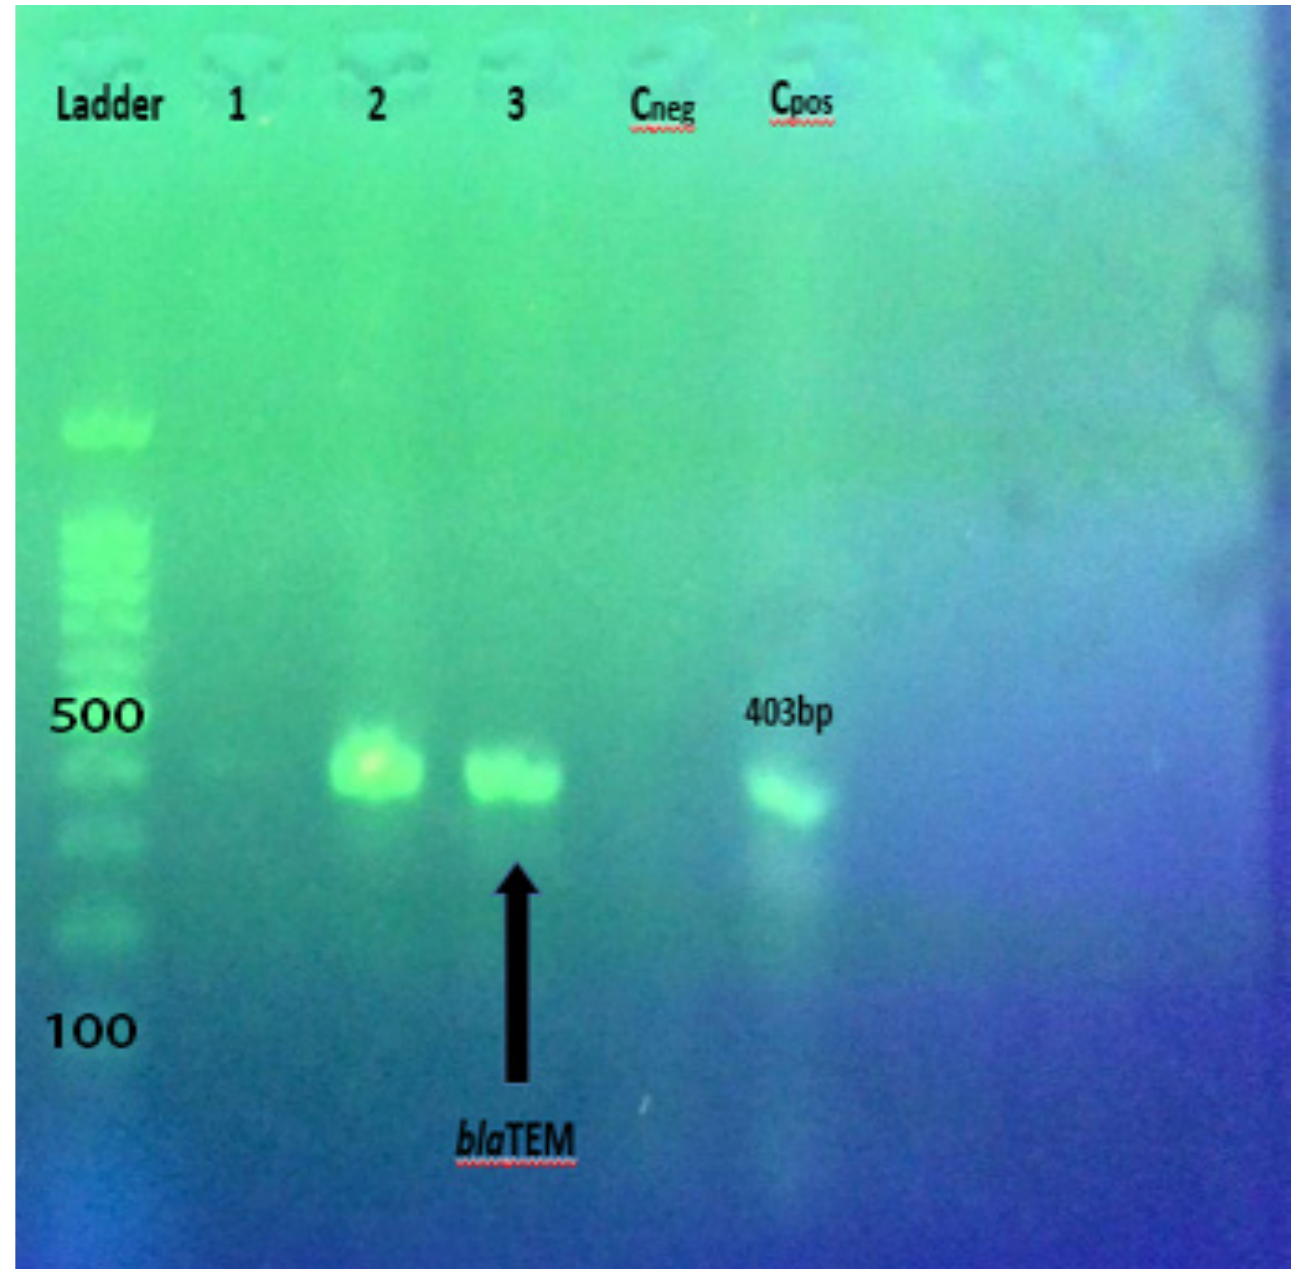
Figure 1. The result of PCR for bla gene.C-pos: Positive control, C-neg: Negative control, Left line: 100bp DNA ladder, Line 1: negative TEM isolate, Line 2 and 3: Positive isolates